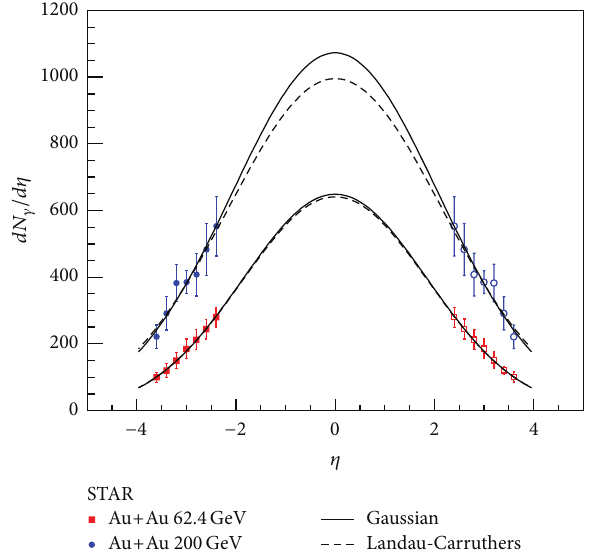
Figure 25: Photon multiplicity distributions of Cu+Cu collision system as a function pseudorapidity for the most central events for different collision energies.